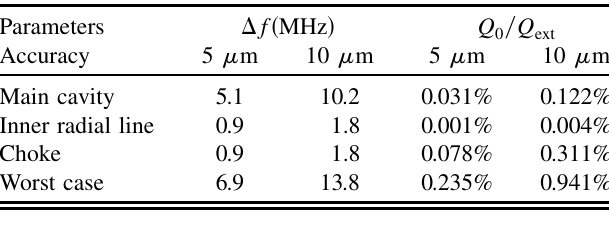
ffiffiffiffiffiffiffiffiffiffiffiffiffiffiffiffiffiffiffiffiffiffiffiffiffiffiffiffi N (cid:5) þ 1 þ M (cid:5)